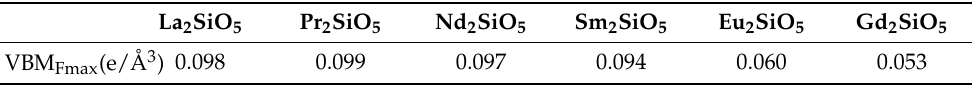
Table 2. The maximum isosurface value of the valence band maximum (VBM Fmax ) of X1-RE 2 SiO 5